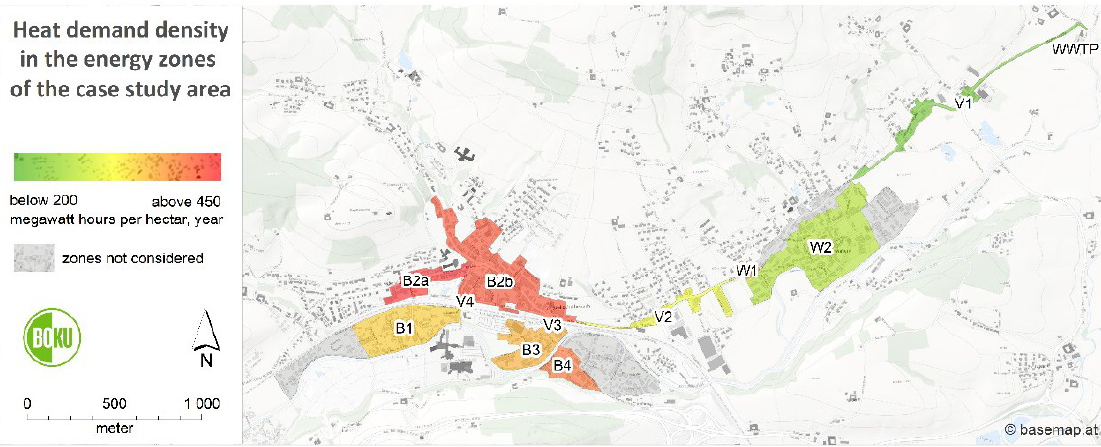
Figure 7. Visualisation of the heat demand density in the relevant energy zones of the case study municipalities (own